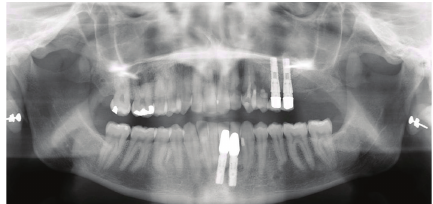
Figure 10: Patient 2: panoramic radiograph taken in 2007 demon- strating gradual resorption of the left-sided maxillary teeth when compared to the panoramic radiograph taken in 2004, demon- strated in Figure 8.